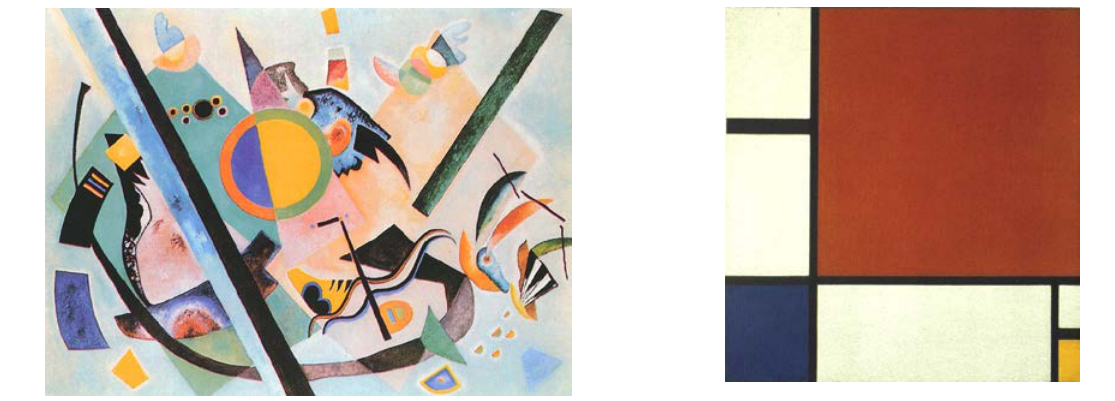
Figure 9 Kandinsky, multi colored circle,1921, Yal university, Art Figure 10 Monderian, composition with Red Blue, Yellow 1930, gallery, oil on canvas,77×101cm . oil on canvas, metropolitan museum of 11T